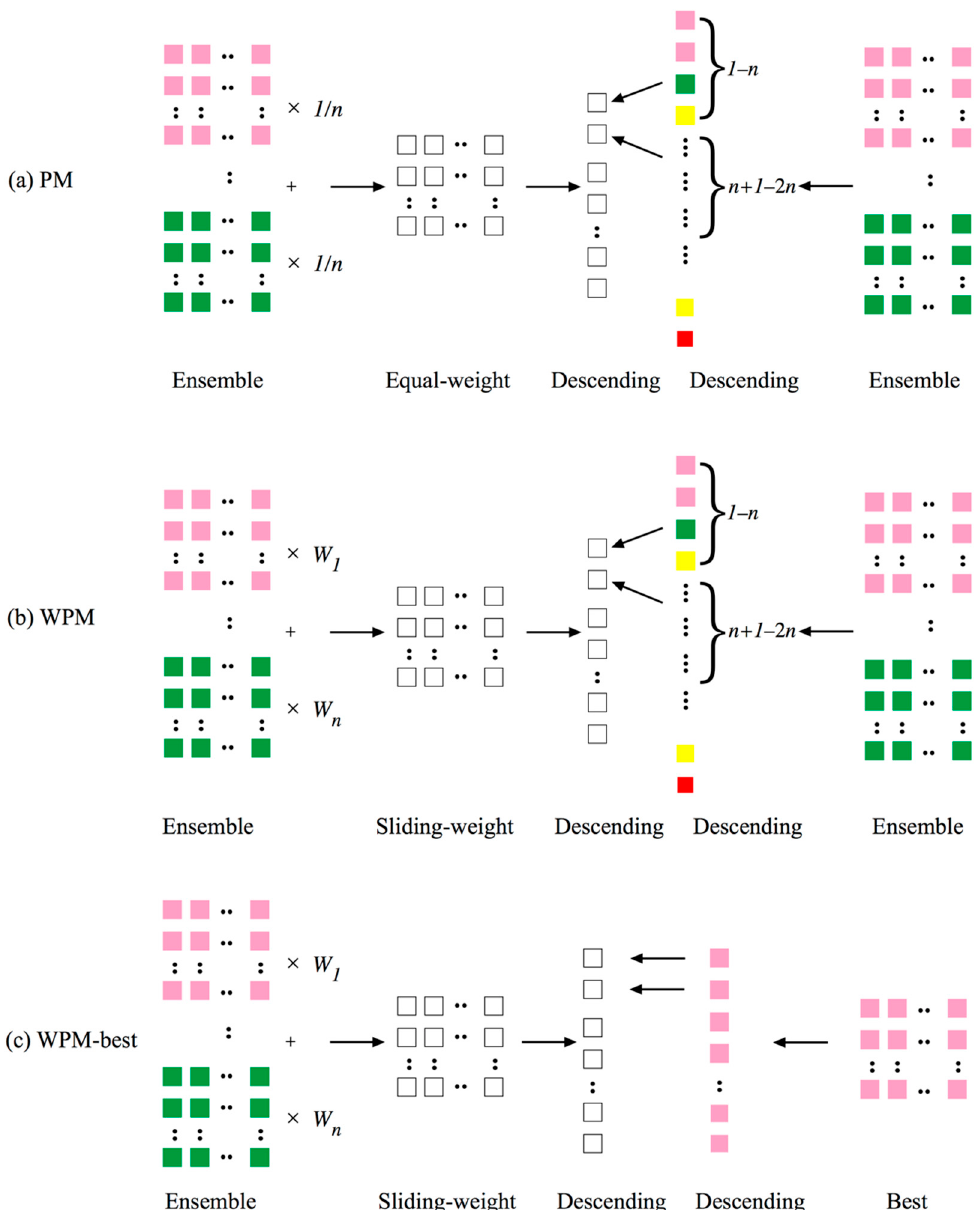
Figure 3. Schematic of the sensitivity experiments and sliding weight denotes WMA.